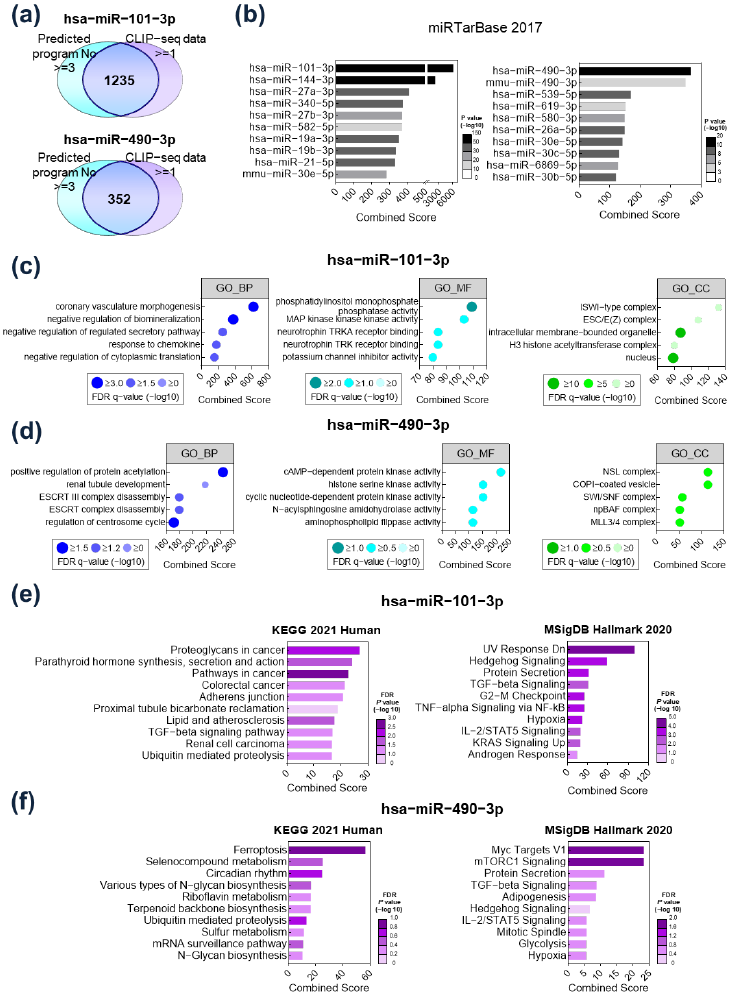
Figure 2. Functional analysis of target gene signatures regulated by hsa-miR-101-3p and hsa-miR-490-3p . ( a ) Overlapping target genes of hsa-miR-101-3p and hsa-miR-490-3p predicted by the ENCORI tool (https://starbase.sysu.edu.cn/ accessed on 12 January 2022) and CLIP-seq data. ( b ) Validation of the hsa-miR-101-3p and hsa-miR-490-3p target genes by miRTarBase. ( c ) Top 5 Gene Ontology classifica- tions of the hsa-miR-101-3p target genes in biological processes (left), molecular functions (middle), and cellular components (right). ( d ) Top 5 Gene Ontology classifications of the hsa-miR-490-3p target genes in biological processes (left), molecular functions (middle), and cellular components (right). ( e ) Pathway enrichment analysis of the hsa-miR-101-3p target genes using KEGG 2021 Human and MSigDB Hallmark 2020. ( f ) Pathway enrichment analysis of the hsa-miR-490-3p target genes using KEGG 2021 Human and MSigDB Hallmark